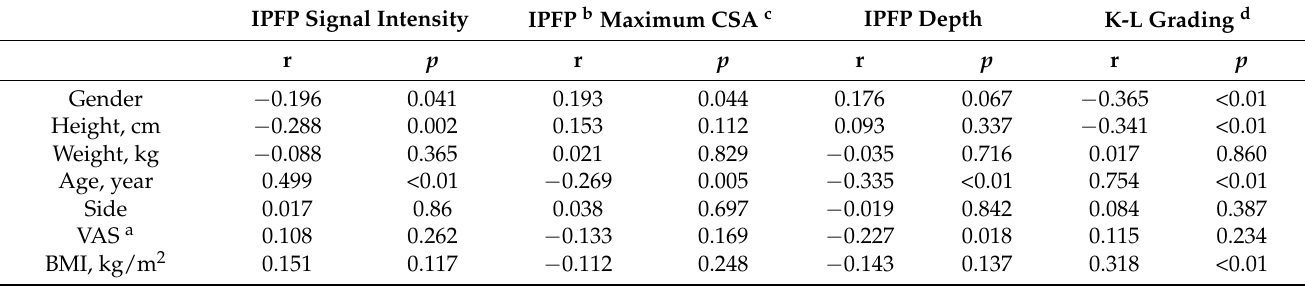
Table 2. Correlation of gender, height, weight, age and location, VAS a scoring and BMI with IPFP b signal intensity, IPFP maximum CSA c , IPFP depth and K-L grading d .